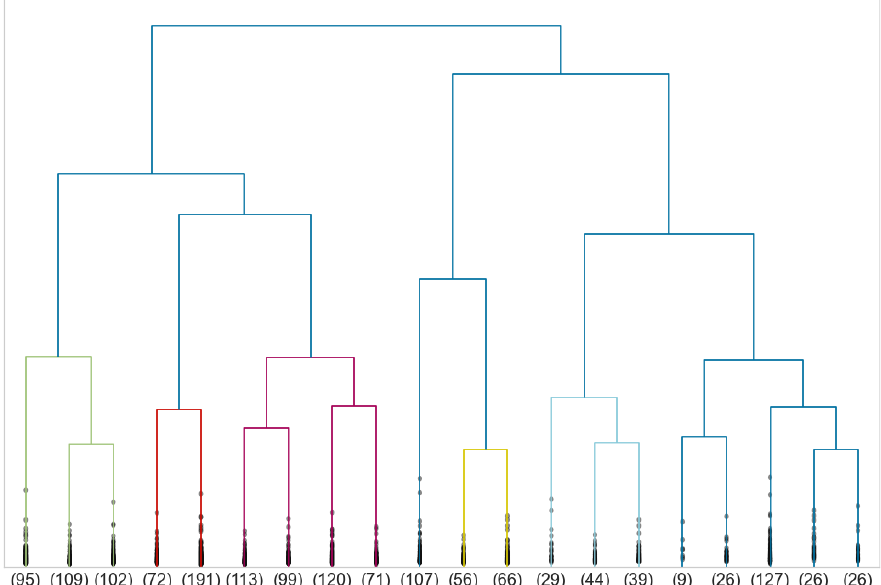
Figure 21. Dendrogram associated to a Ward-linkage hierarchical clustering of the silhouettes of the persistence diagrams of female point